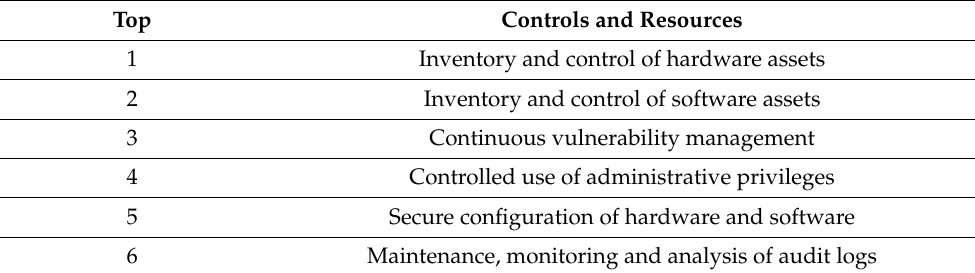
Figure 4. Projected research based on proposals. Table 4. Center for Internet Security (CIS)